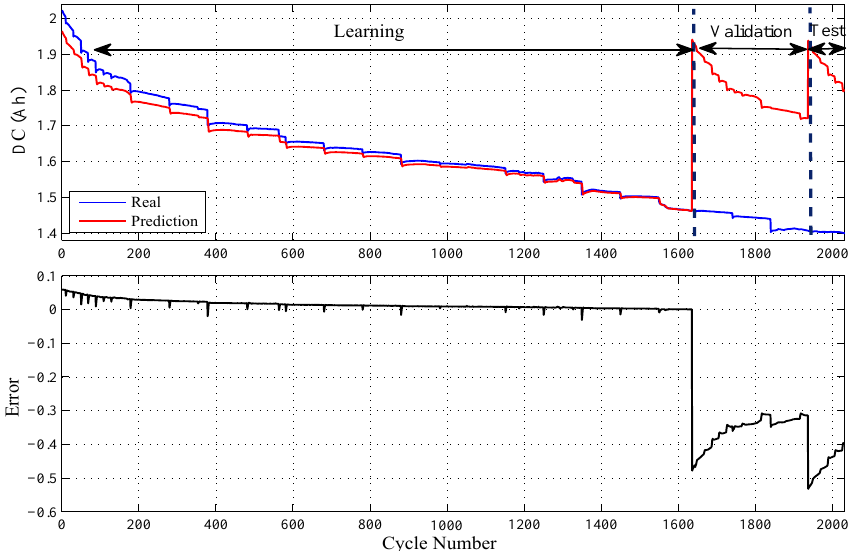
Figure 7. Evolution of real and estimated DCs of the MLSLF